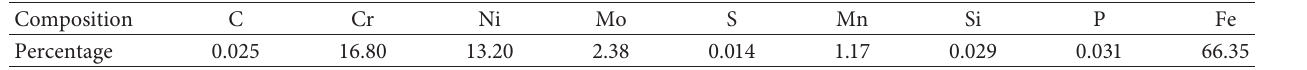
Table 1: Composition of 316L stainless steel.